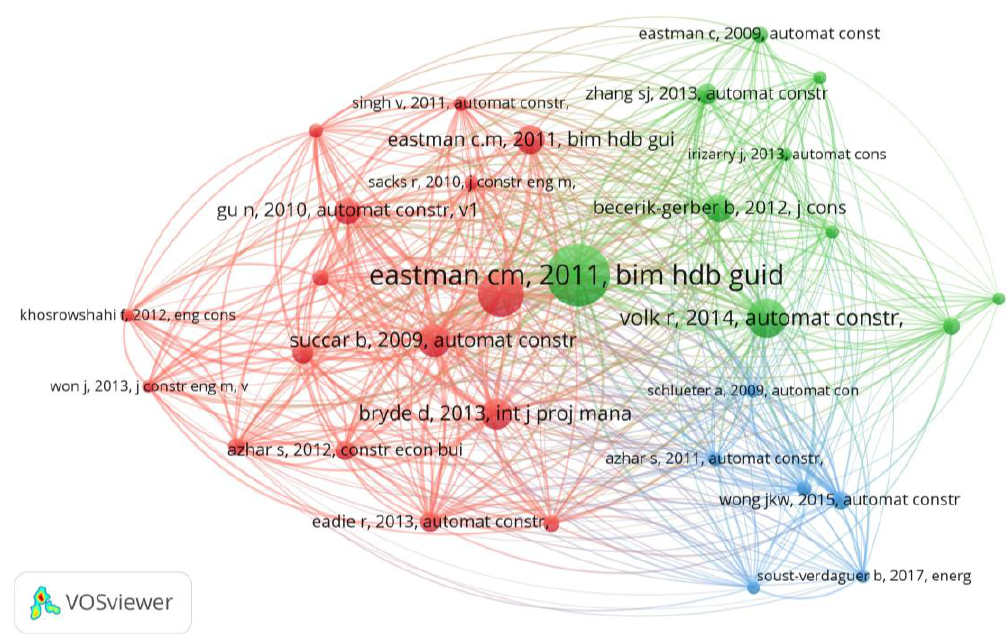
Figure 11. Network of document co-citations. Table 7. The ten most influential papers in the studied field.